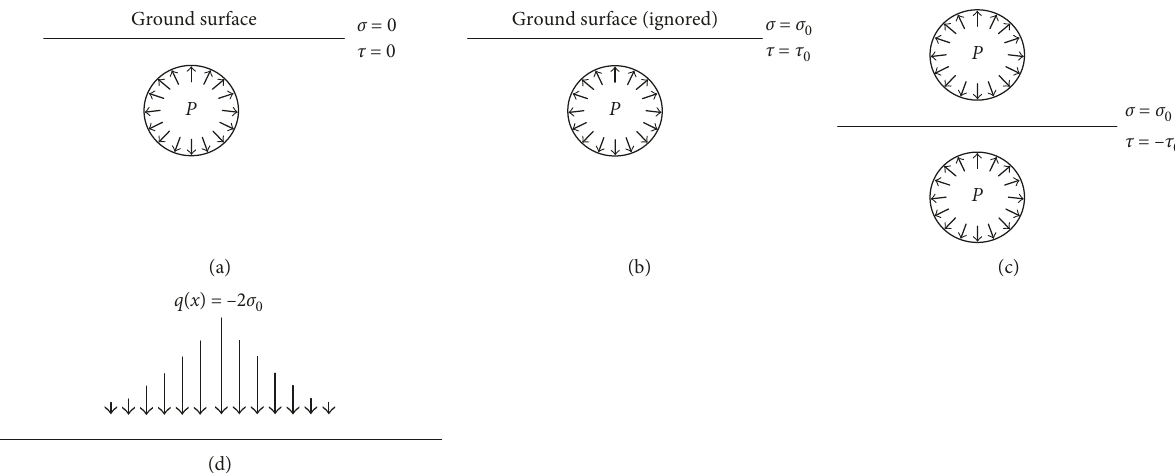
Figure 2: Steps in the analysis: (a) actual problem; (b) infinite medium; (c) positive image; (d) surface stresses.